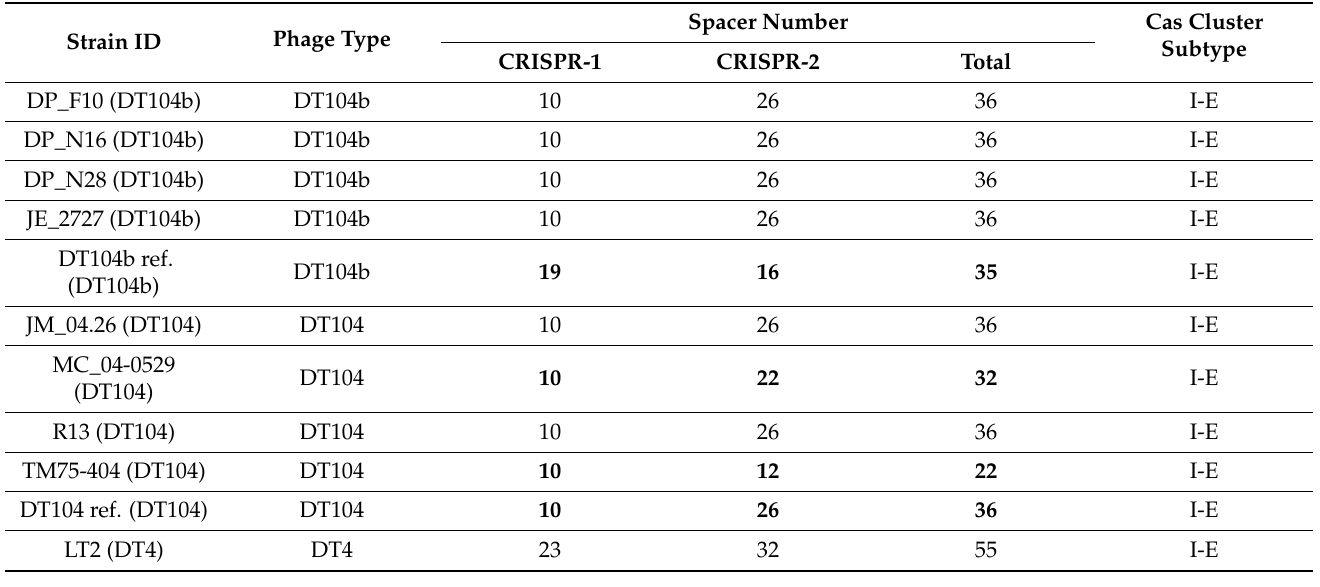
Table 6. CRISPR/Cas systems detected in the studied S . Typhimurium genomes.